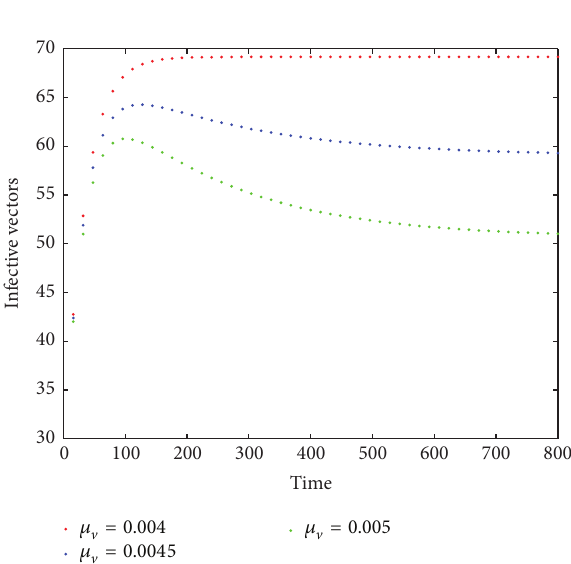
Figure 4: The effect of 𝜇 V on infected vectors for Π ℎ = 0.22 , Π V = = 0.02 , 𝜔 = 0.03 , 𝜇 = 0.004, 0.0058, 0.09 , 𝛽 0.32 , 𝜇 ℎ V = 0.00034 , 𝛿 = 0.0016 , 𝛿 = 0.00016 , 𝜃 = 0.00301 , 𝛼 𝛽 2 1 2 and 𝛼 2 = 0.001